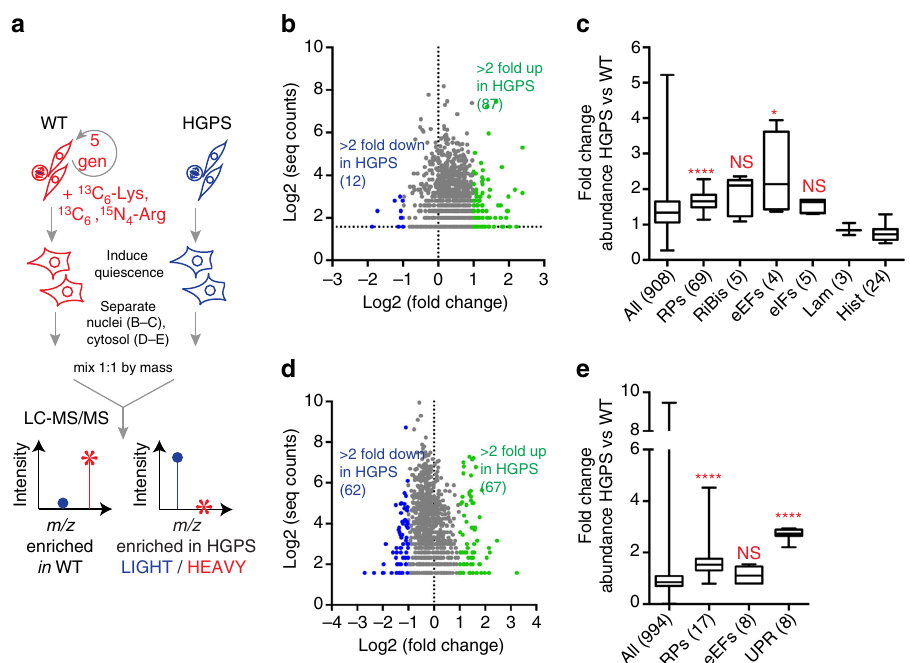
Fig. 4 Elevated production of ribosomal proteins in HGPS. a Overview of SILAC abundance analysis strategy. Proliferating WT fi broblasts were cultured for fi ve generations in media containing stable heavy isotopes to completely label cellular proteins. Parallel cultures of HGPS fi broblasts were expanded in normal media. Quiescence was induced; crude nuclear and cytosolic fractions were prepared, and equal masses of fractions were mixed and analyzed by LC-MS/MS. b , d Number of peptides detected vs. fold change in abundance on a logarithmic scale for b 908 proteins identi fi ed in nuclei and d 994 proteins identi fi ed in cytosol prepared from SILAC-labeled wild type (AG3258) and HGPS (AG11498) cells. c , e ) Analysis of relative c nuclear and e cytosolic protein abundance by functional class. Subunits of the small and large ribosome (RPs); ribosome biogenesis proteins (RiBis); translation elongation factors (eEFs); translation initiation factors (eIFs); lamins (lam); histones (hist); UPR target genes (UPR). Boxes indicate 25th – 75th percentile, lines indicate median values, and bars indicate range of values. Signi fi cance determined by Mann – Whitney U -test. See also Supplementary Data